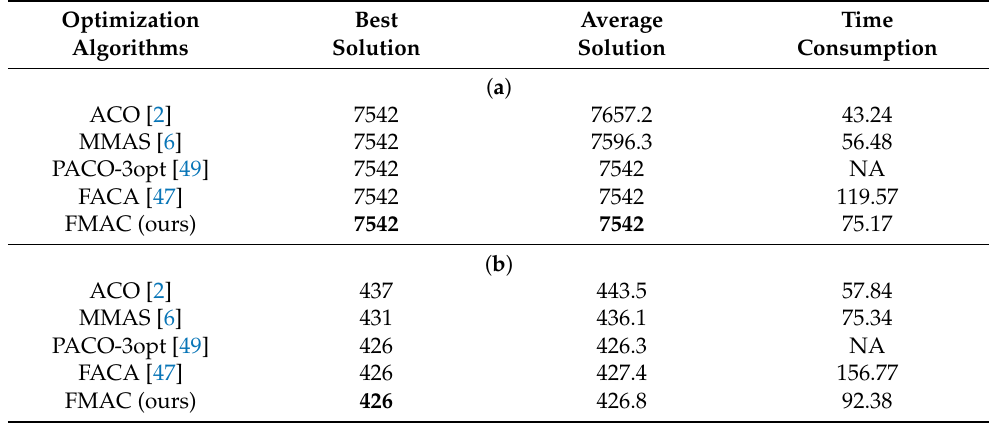
Table 4. Performance of experiment: ( a ) berlin52; ( b ) eil51; ( c ) eil76; ( d ) eil101; ( e ) rat99, and ( f ) st70 (NA in table means no data were obtained from the PACO-3opt paper).